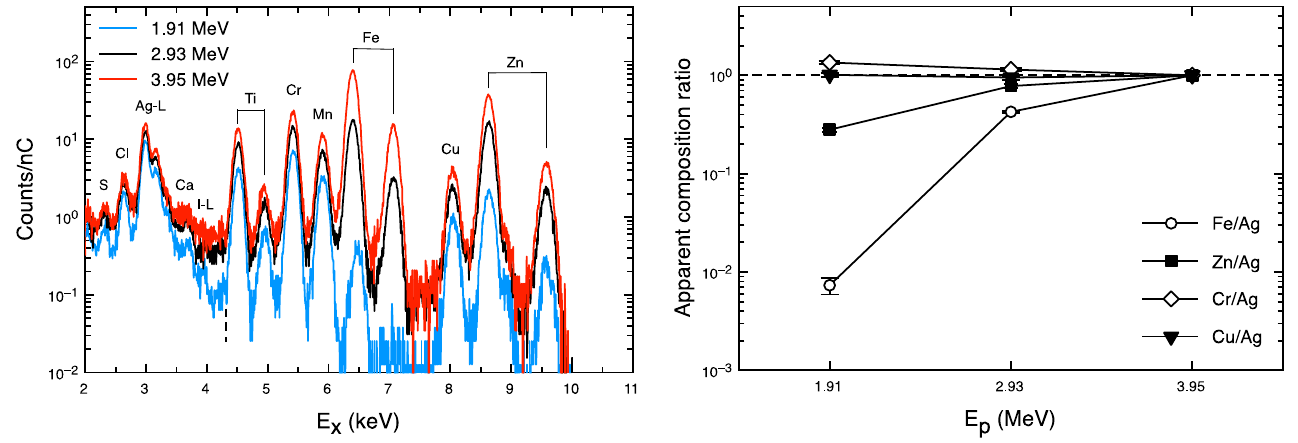
Figure 3. On the left, comparison between PIXE spectra of a tintype at three different proton energies, namely, 2, 3, and 4 MeV; the reported beam energies refer to the effective values at the sample surface, after traversing the beam exit window and about 1 cm path in external atmosphere. The spectra are normalised by the proton beam charge accumulated during the measurements. On the right, the apparent composition ratios of the main metallic elements as a function of the different proton beam energies.